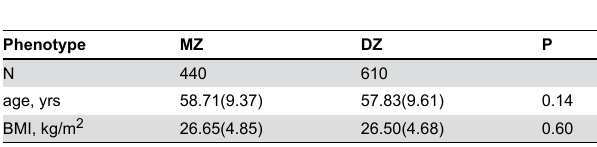
Table 1. Demographic characteristics of the study population, mean (SD